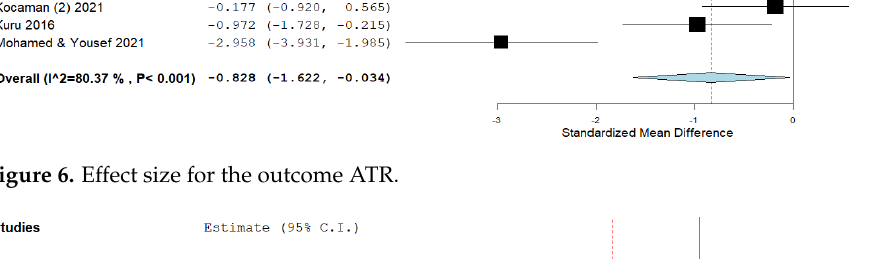
Figure 6. Effect size for the outcome ATR.